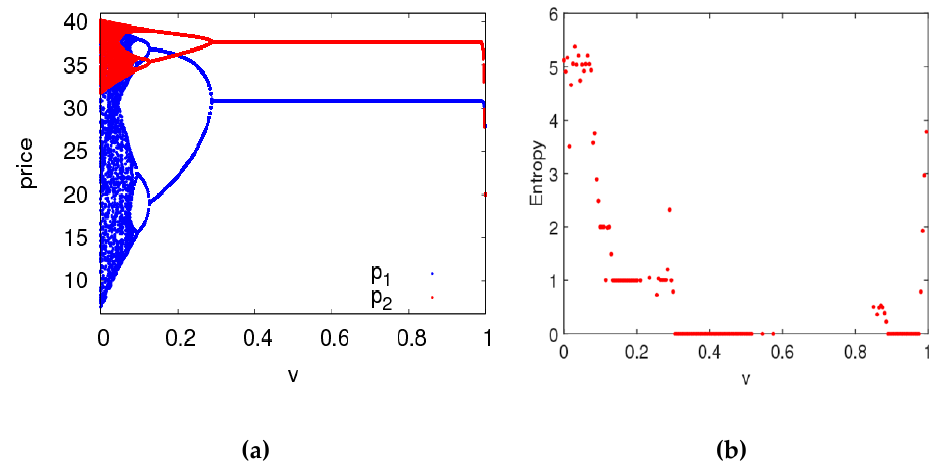
Figure 22. Bifurcation diagram and entropy of control system (12) with v ∈ ( 0, 1 ) when α 1 = 0.015, α 2 = 0.008. ( a ) The bifurcation diagram, ( b ) The entropy diagram